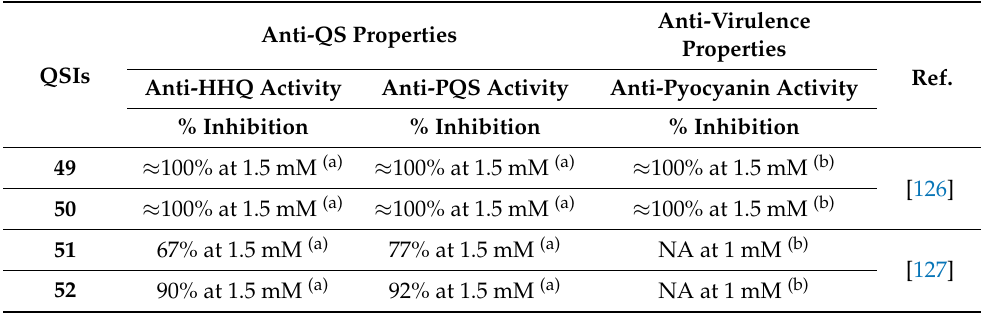
Table 6. Anti-QS and anti-virulence properties of PqsA